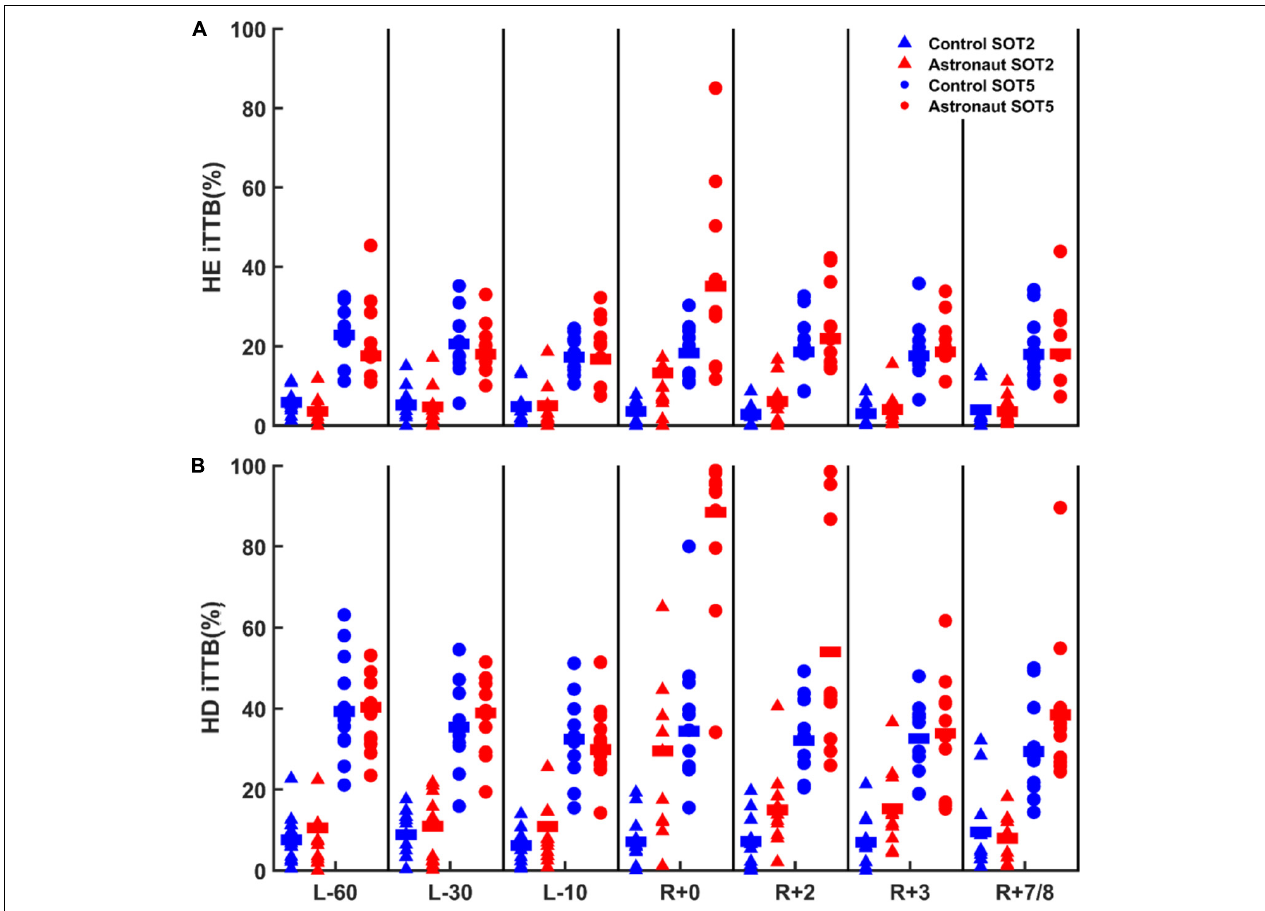
FIGURE 3 | Postural control performance (iTTB) data from all control (blue symbols) and astronaut subjects (red symbols) for static (SOT-2, triangles) and dynamic (SOT-5, circles) support surface conditions during head erect (HE; A ) and head dynamic (HD; B ) head orientation conditions. Group means in each condition and testing session are shown by solid horizontal